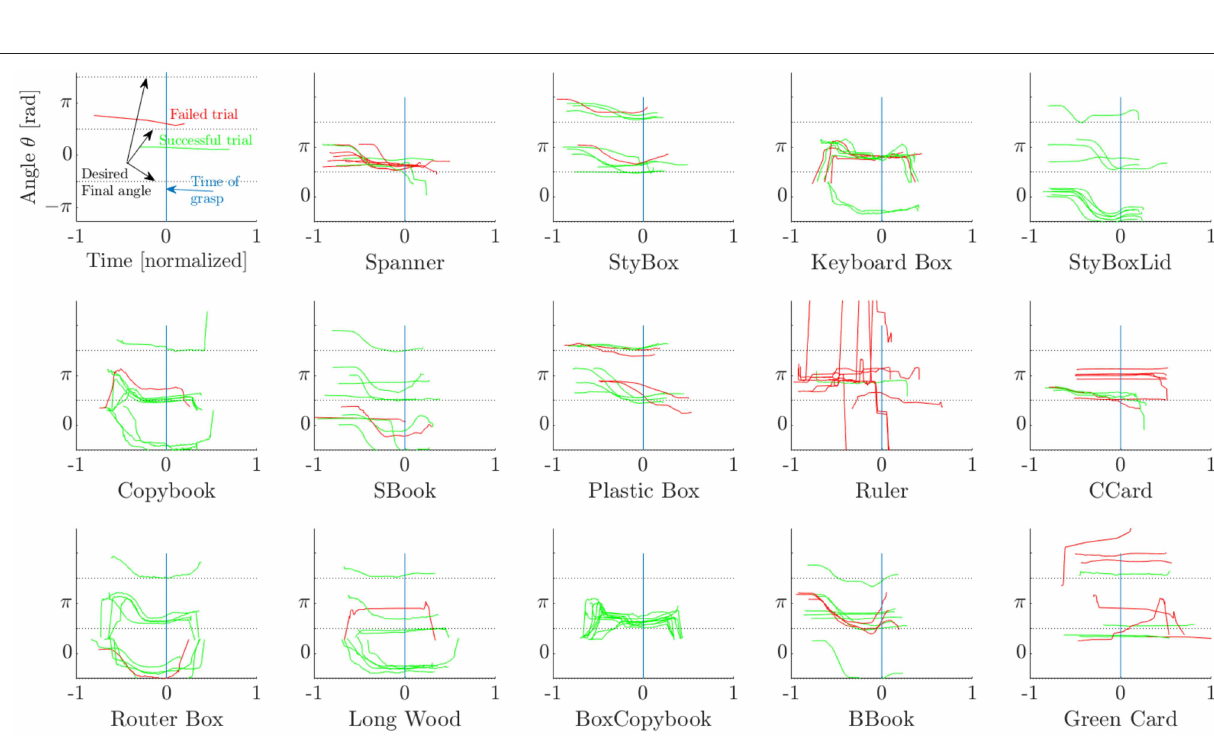
Frontiers in Robotics and AI |